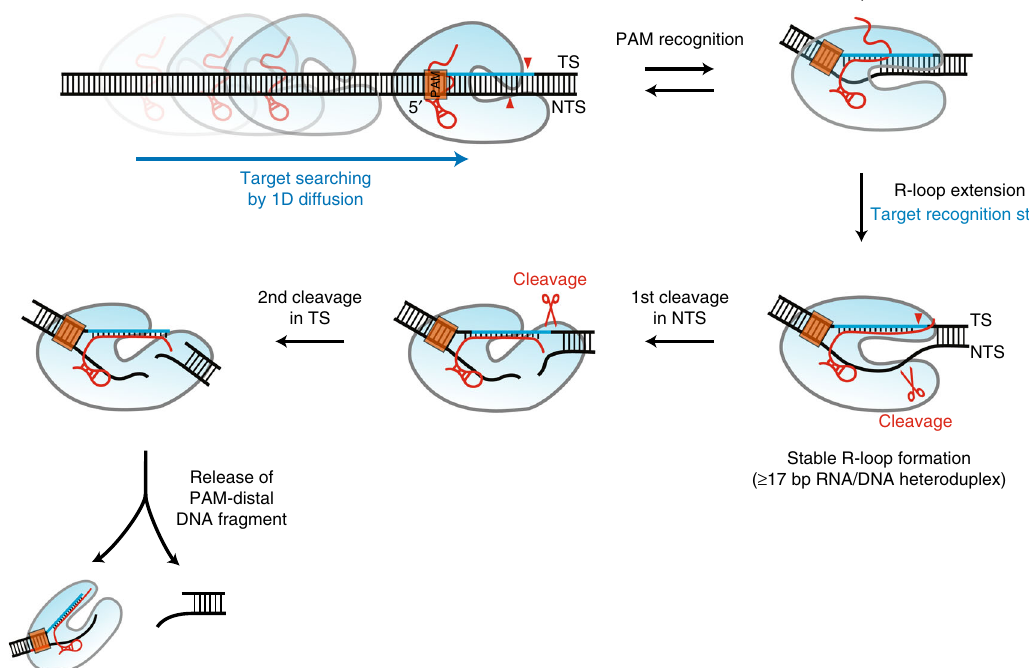
Fig. 6 Proposed model for DNA target recognition and cleavage by AsCas12a RNP. An AsCas12a RNP fi rst binds dsDNA and then diffuses along it (facilitated target searches including 1D diffusion). When an AsCas12a RNP encounters its target site, PAM-induced local unwinding by AsCas12a mediates DNA – RNA base pairing for checking complementarity (R-loop initiation). If the length of the R-loop is not suf fi cient (<17 bp), the AsCas12a RNP easily comes off the DNA (low stability under partial R-loop formation). Once a suf fi ciently long R-loop is formed ( ≥ 17 bp), the AsCas12a RNP strongly holds the DNA and is ready for DNA cleavage. After stable R-loop formation, AsCas12a sequentially cleaves the DNA, fi rst the non-target strand and then the target strand, regardless of the presence of a PAM (PAM-independent sequential DNA cleavage). After successful DNA cleavage, AsCas12a quickly releases the PAM-distal DNA fragment but continues to hold the other fragment that contains both the PAM and